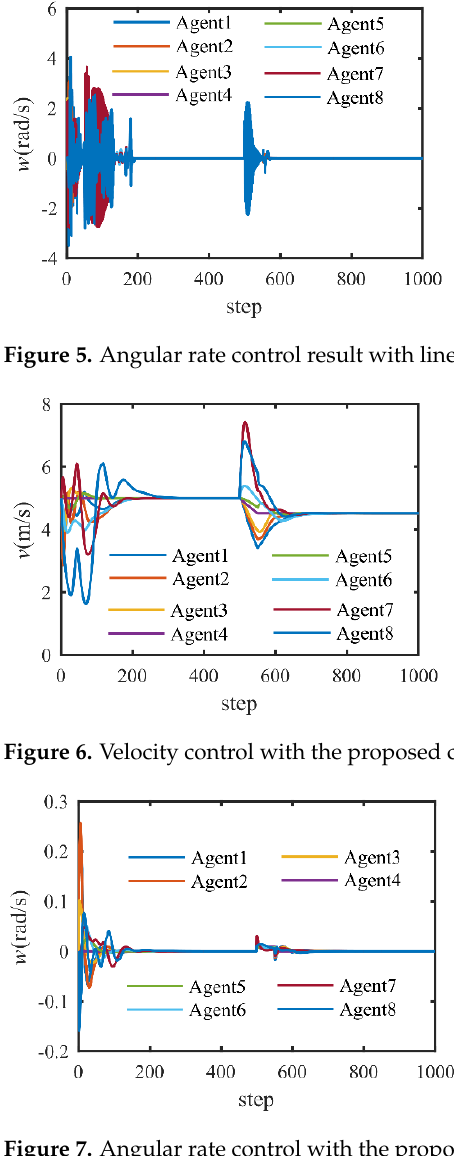
13 of 19 Figure 2. Position errors with the proposed controller. Figure 3. Position errors with linear controller.